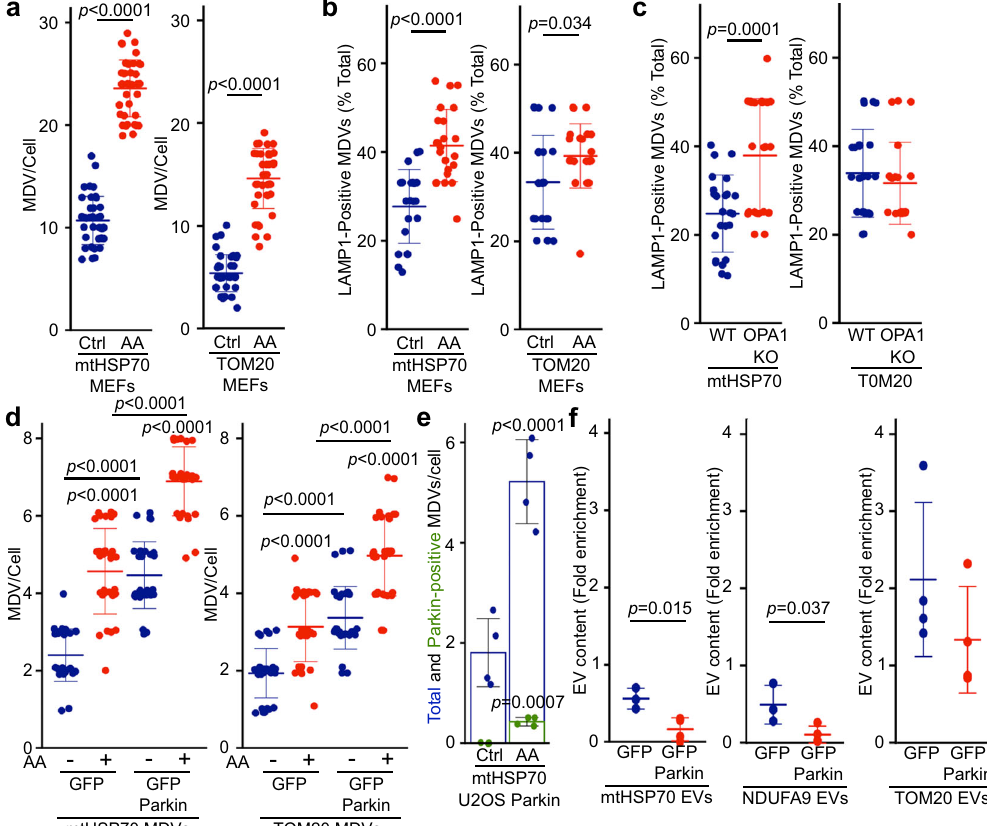
Fig. 7 Parkin activation inhibits the inclusion of mitochondrial proteins within EVs. a AA treatment induces MDV formation. WT MEFs grown on coverslips were incubated in the absence (blue) or presence of AA for 1 h (red). mtHSP70 and TOM20 MDVs were then quanti fi ed. Each data point represents one cell. Bars represent the average of at least 30 cells in a minimum of three independent experiments ± SD. Two-sided t -test. b , c Damage- induced MDVs are targeted to lysosomes. b WT MEFs were treated as in ( a ) in the presence of E64/Pepstatin and MDV associaton with the lysosomal marker LAMP1 quanti fi ed as the fraction of total MDVs associated with LAMP1. Alternatively ( c ) LAMP1-positive MDVs were quanti fi ed from OPA1 KO MEFs. Each data point represents one cell. Bars represent the average of at least 20 cells in a minimum of three independent experiments ± SD. Two-sided t -test). d Stable expression of GFP-Parkin increase MDV formation. U2OS cells stably expressing GFP (blue) or GFP-Parkin (red) were treated with AA for 4 h and MDVs quanti fi ed. Each data point represents one cell. Bars represent the average of at least 20 cells in a minimum of three independent experiments ± SD one-way ANOVA. e mtHSP70 MDVs association with Parkin. U2OS cells stably transfected with GFP-Parkin were treated as in ( d ) and the association of mtHSP70 MDVs quanti fi ed by immuno fl uorescence. Individual points represent independent experiments ( n = 4). Bars show the average percent of the total (blue) and Parkin-positive (green) mtHSP70 MDVs± SD. Two-sided t -test. f GFP-Parkin expression impairs the inclusion of IM/matrix proteins into EVs. EVs were isolated from U2OS cells stably expressing GFP (blue) or GFP-Parkin (red) and the indicated mitochondrial proteins measured as in Fig. 1. Individual points represent independent experiments ( n = 3, except for TOM20 where n = 4). Bars show the average ±SD. Two-sided t